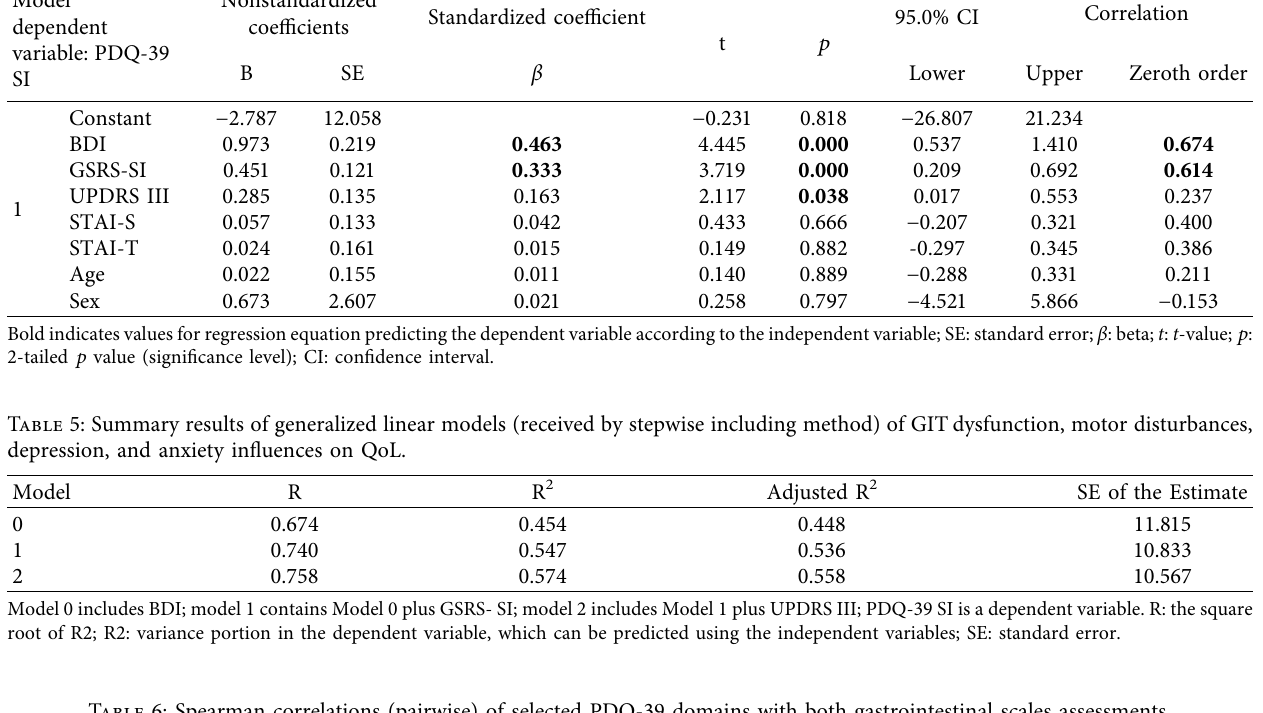
Table 6: Spearman correlations (pairwise) of selected PDQ-39 domains with both gastrointestinal scales assessments. PDQ-39 Mobility Daily activity Emotional wellbeing Stigma Social support Cognition Communication Bodily discomfort GSRS-SI 0.406